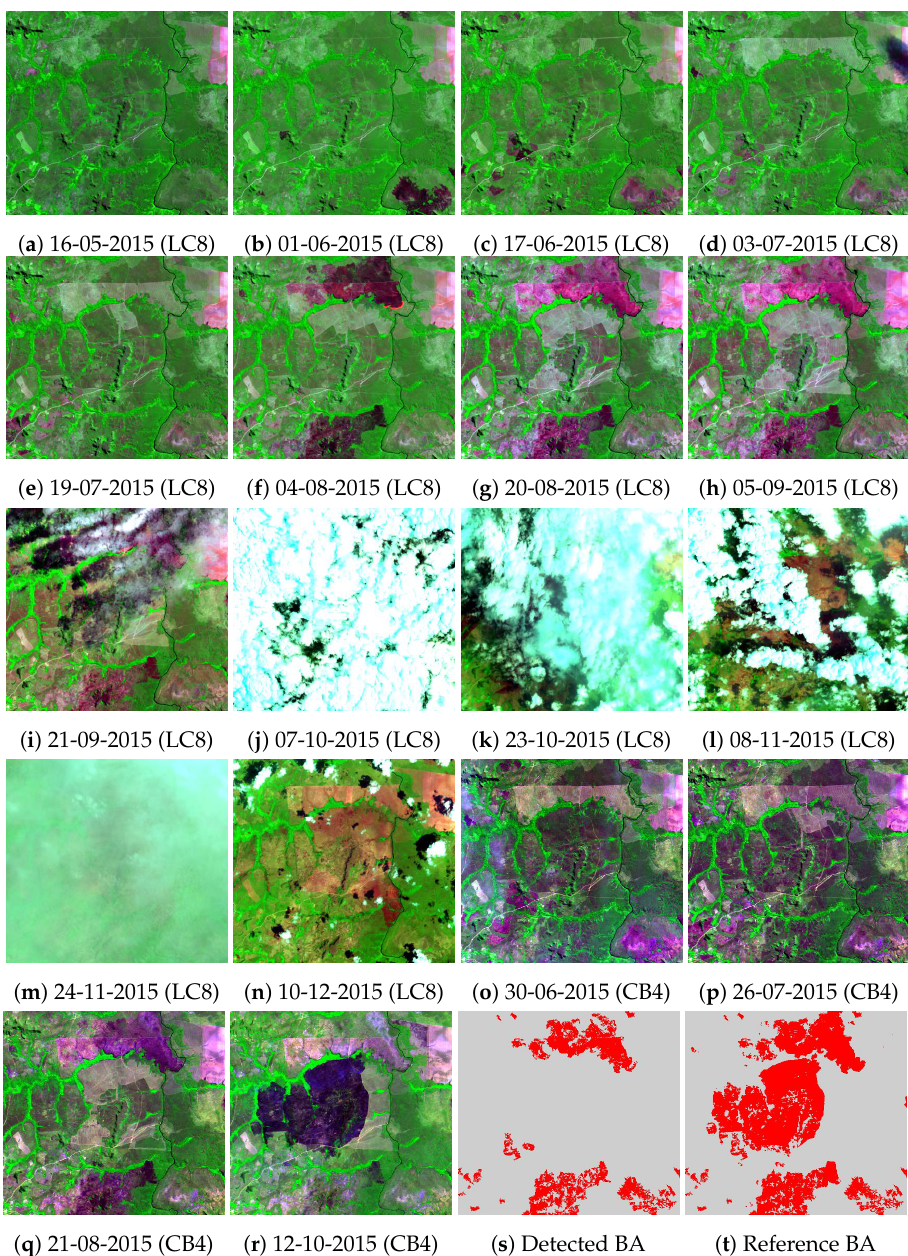
Figure 11. Example of the omission error of GABAM 2015. ( a – n ) are Landsat-8 image patches displayed in false color composition (red: SWIR2 band, green: NIR band, and blue: green band); ( o – r ) are CBERS-4 image patches displayed in false color composition (red: NIR band, green: red band, and blue: green band); ( s , t ) show the detected BA and reference